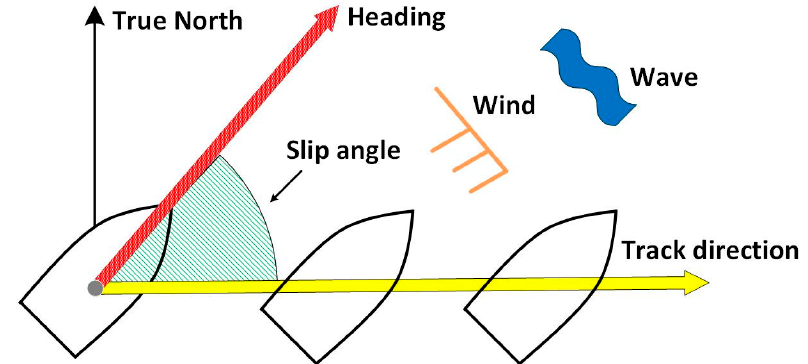
Figure 2. Heading and track directions.